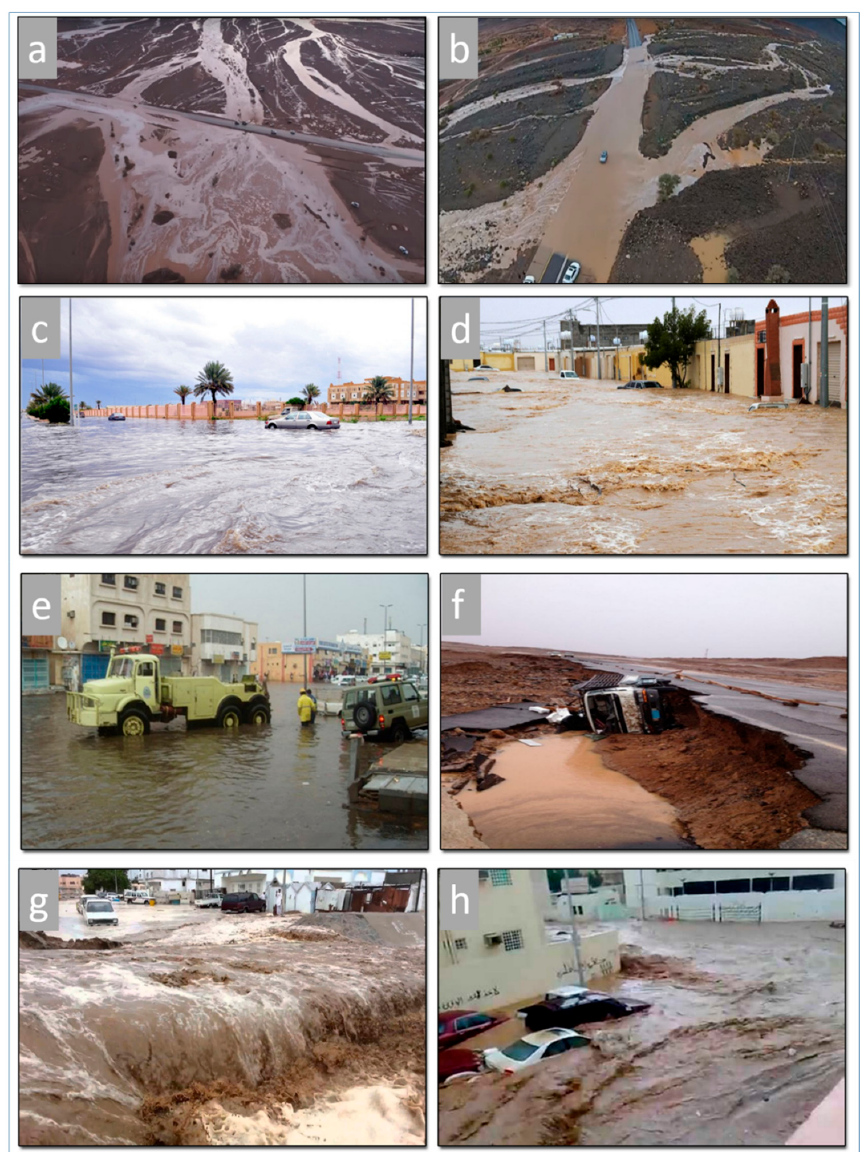
Figure 2. Field photos showing large portions of Tabuk City completely inundated with water and mud during flood events of 2016 (a–d) and 2013 (e–h). ( a,b ) Aerial photographs showing flooded areas; ( c,d ) flood water inundating the southern district of Tabuk City; ( e–h ) flash flood waters attacking the eastern district at a depth of more than 50 cm (note undercutting of the highway due to floodwaters in f).